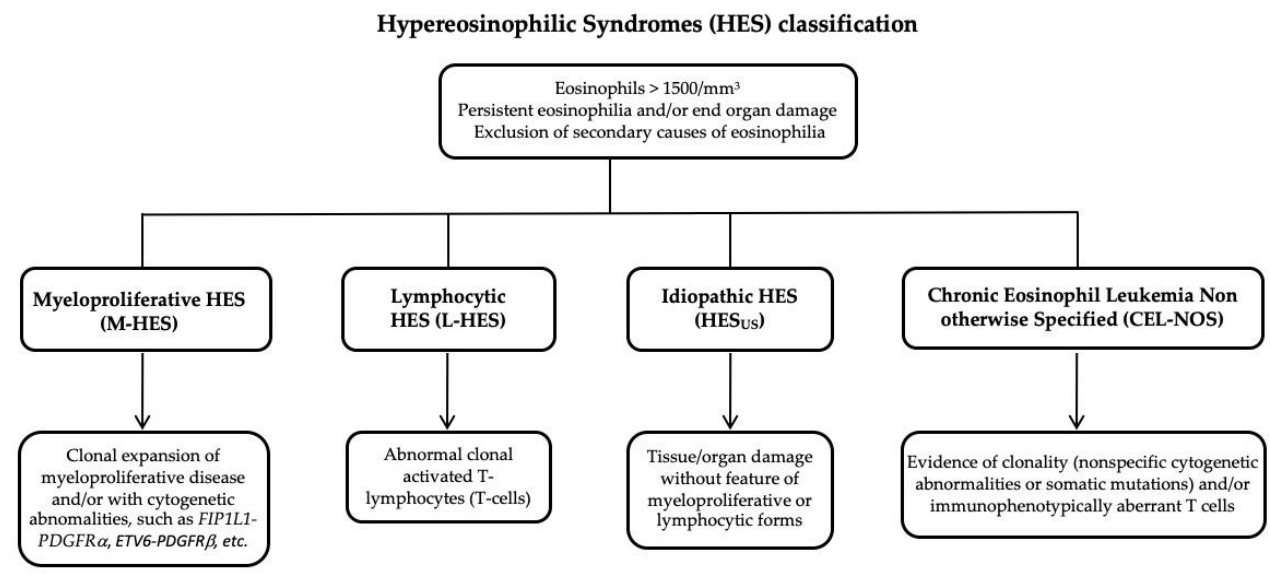
Figure 1. Hypereosinophilic syndromes (HES)